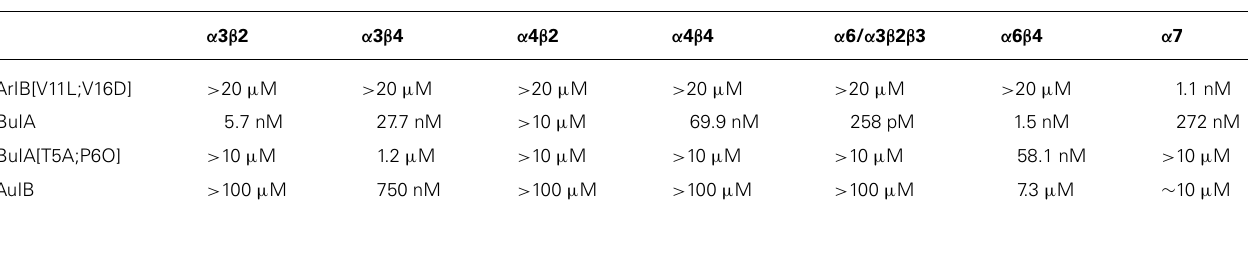
Table 1 | IC 50 values for inhibition of nAChR subtypes by various α -conotoxins and their analogs (adapted from Hone etal.,